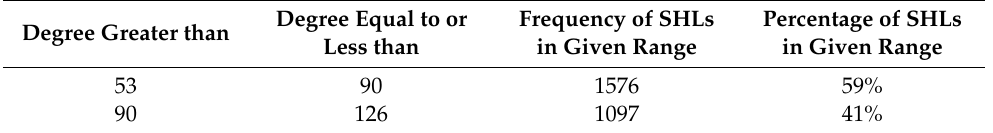
Table 7. Sea horizon line angle